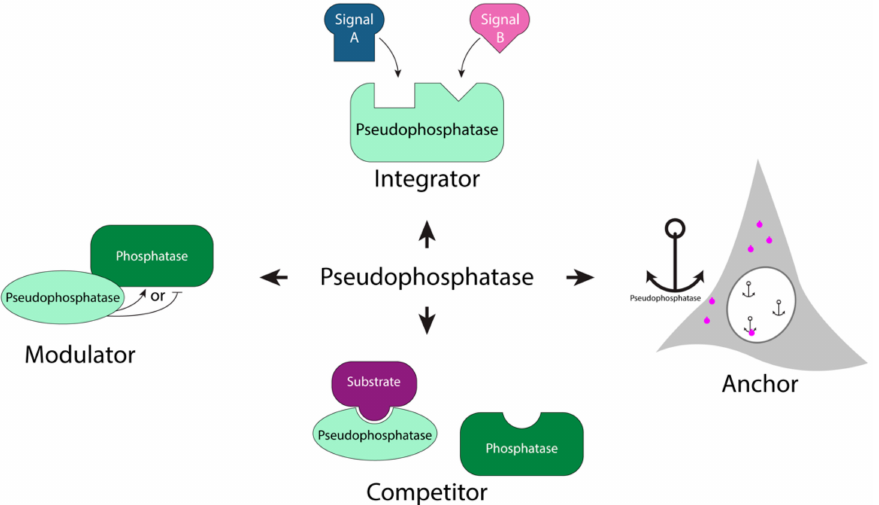
Figure 1. Roles of pseudophosphatases as signaling molecules. There are several different mech- anisms that pseudophosphatases utilize to regulate signaling pathways. They may serve as an integrator and integrate multiple signaling pathways (top); a molecular anchor by binding a target protein and restricting its subcellular localization (right); a competitor for substrate binding (bottom); and as a modulator of enzymes such as an active phosphatase by either promoting or inhibiting the activity of the phosphatase (left) (adapted image)